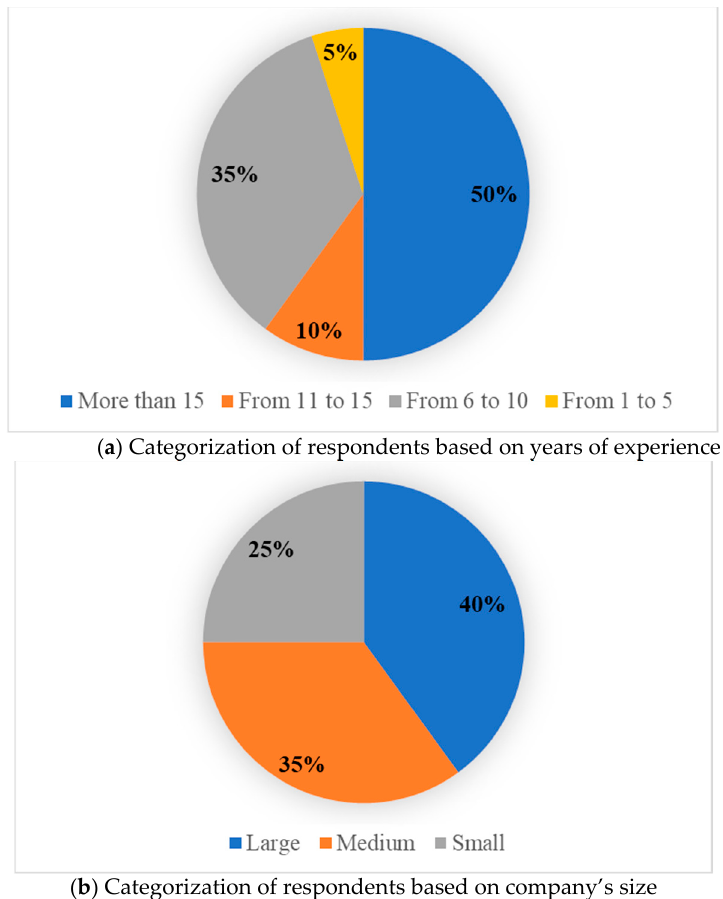
Figure 3. Categorization of respondents based on experts and company’s size.